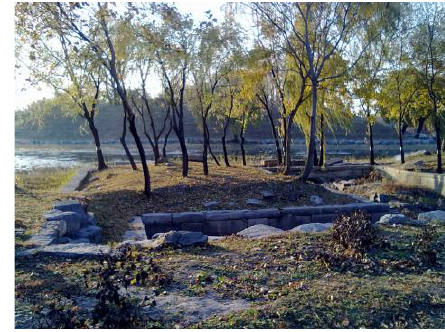
Figure 1. the Old Summer Palace site which is lack